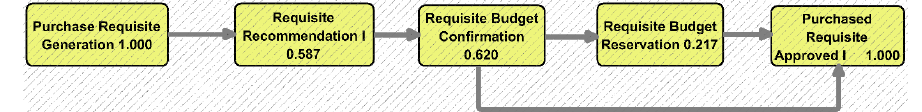
Figure 4. Visualization (dependency graph) for the control flow log using different